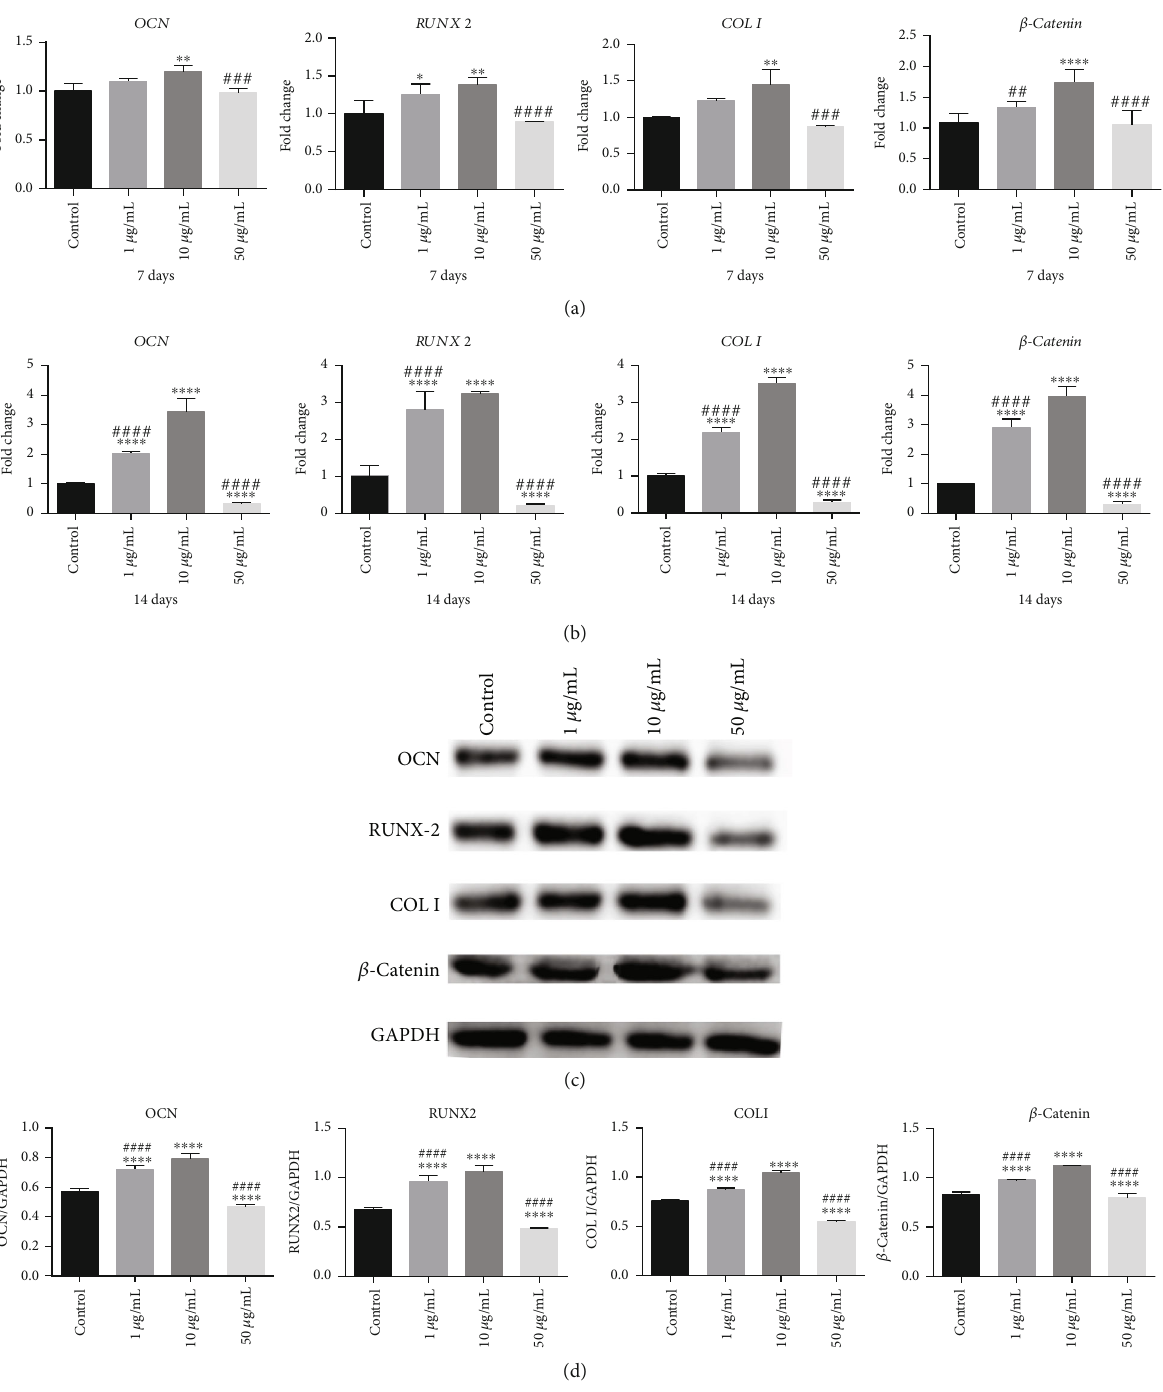
Figure 5: SHEDs were cultured in the osteogenic induction medium containing GOQDs. (a) mRNA extracted at 7 days. (b) mRNA extracted at 14 days. (c) Protein extracted at 14 days. (d) Quanti fi cation of protein levels. ∗ p < 0 : 05 , ∗∗ p < 0 : 01 , ∗∗∗ p < 0 : 001 , and ∗∗∗∗ p < 0 : 0001 vs.